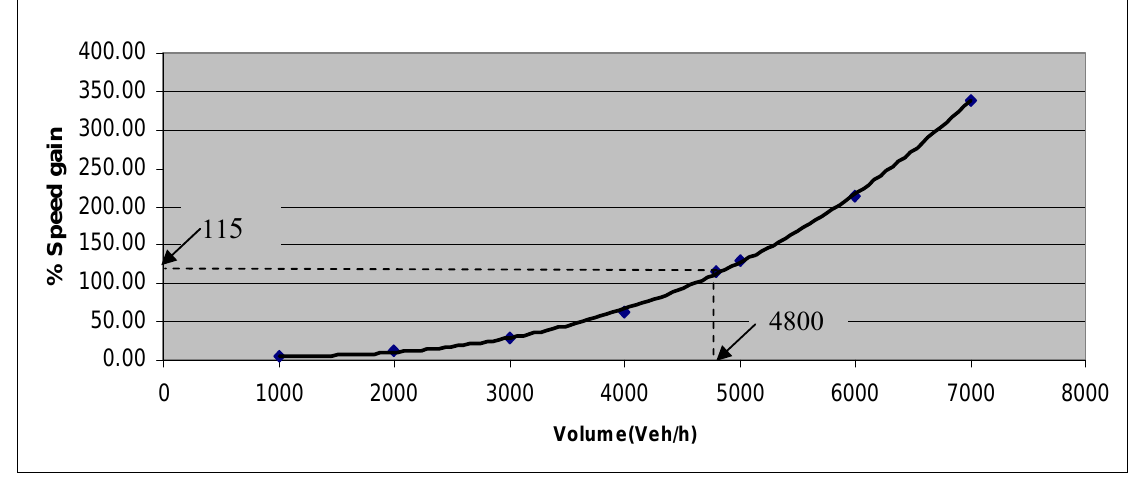
Figure 10. The rate of increase in speed of buses due to provision of exclusive bus